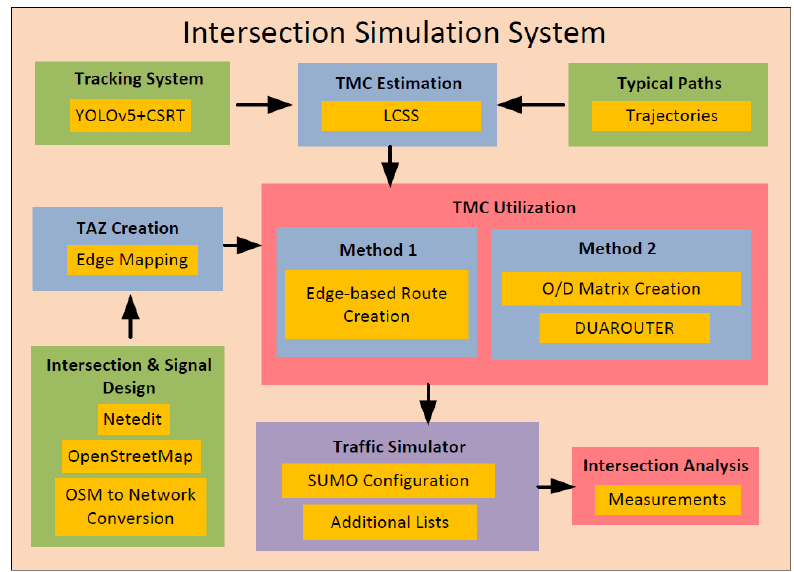
Figure 1. The proposed framework for intersection